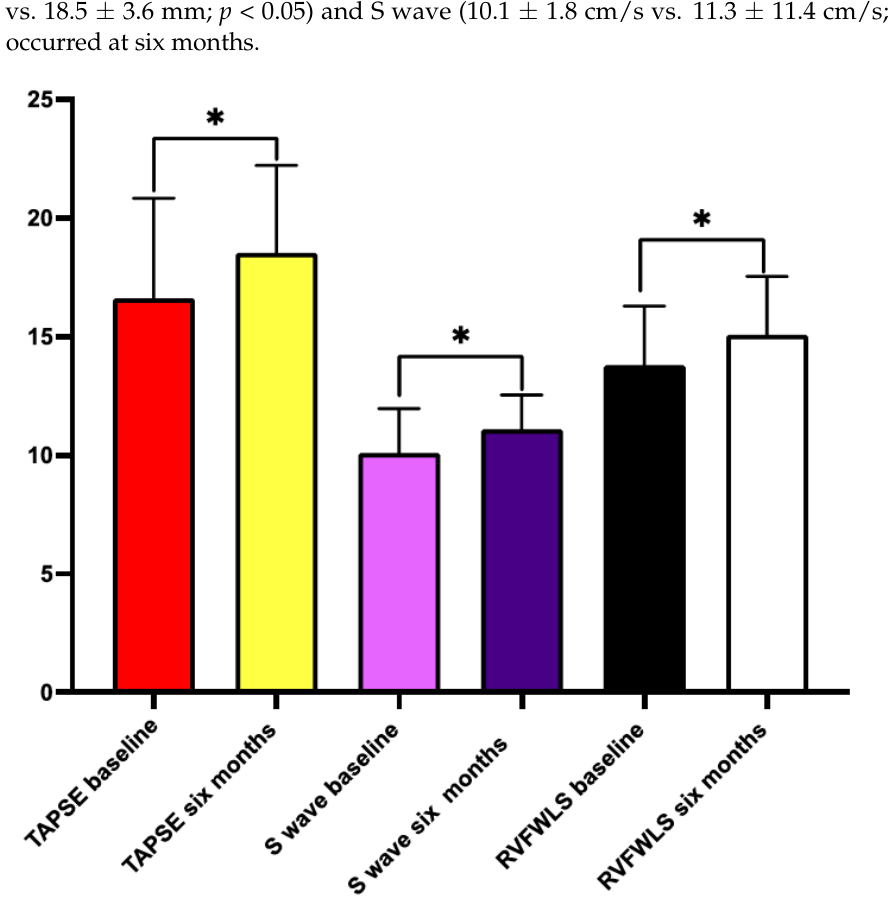
Figure 3. Example of the effects of CCM on TAPSE (panel ( A , C )) and S wave (panel ( B , D )) at six months follow ‐ up.